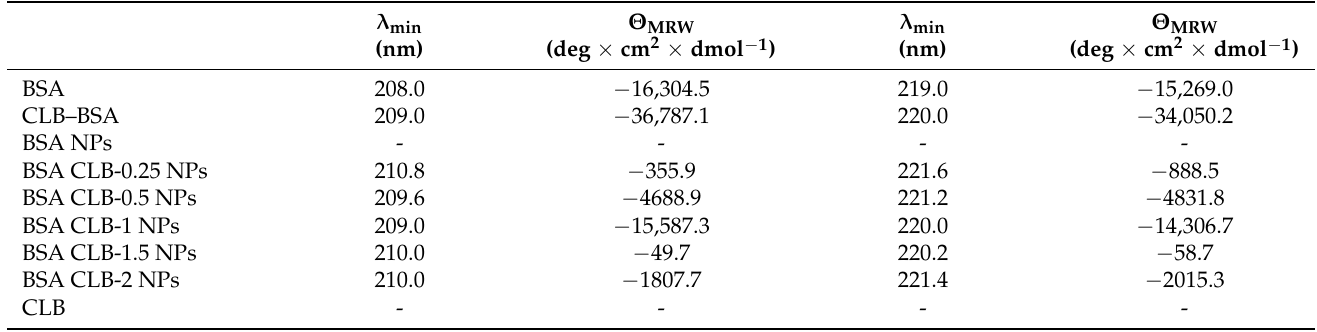
Table 4. The mean residue ellipticity ( Θ MRW ).